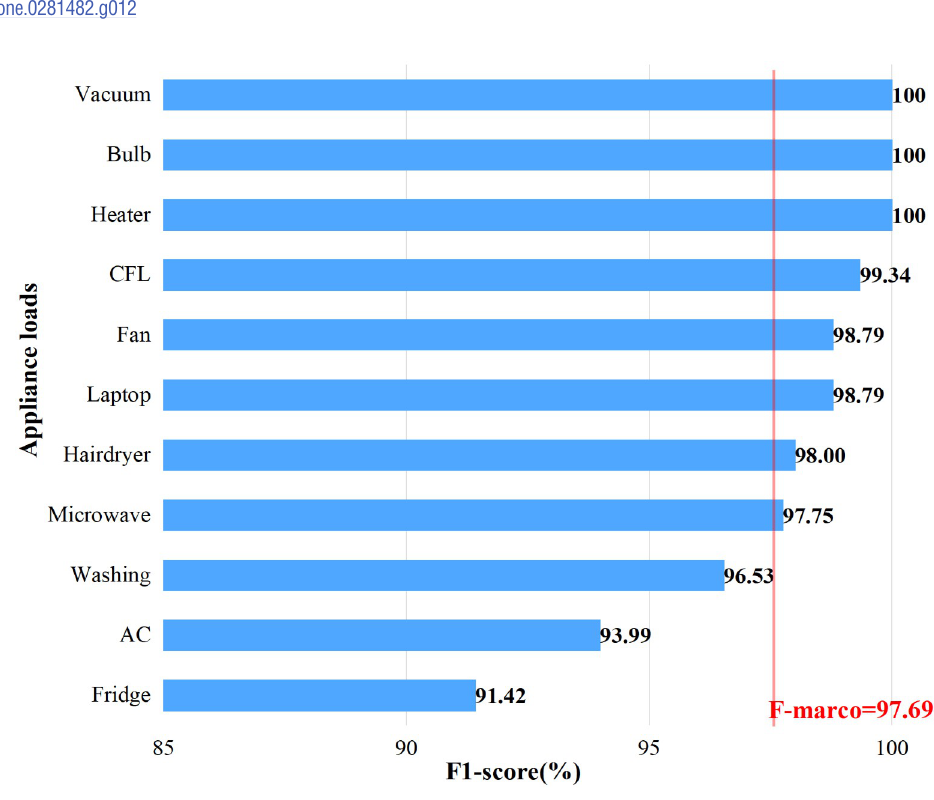
Fig 13. The F-score (%) for appliance loads of the PLAID dataset.